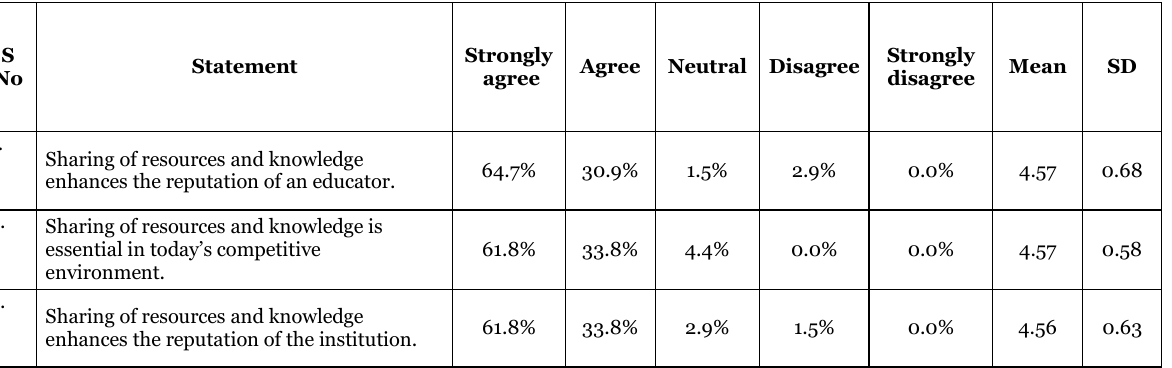
Attitude Towards Sharing of Knowledge and Learning